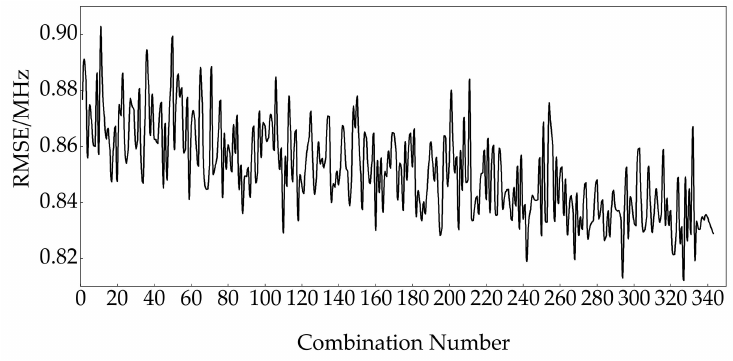
Figure 3. RMSE of ENN model under di ff erent combination of hidden